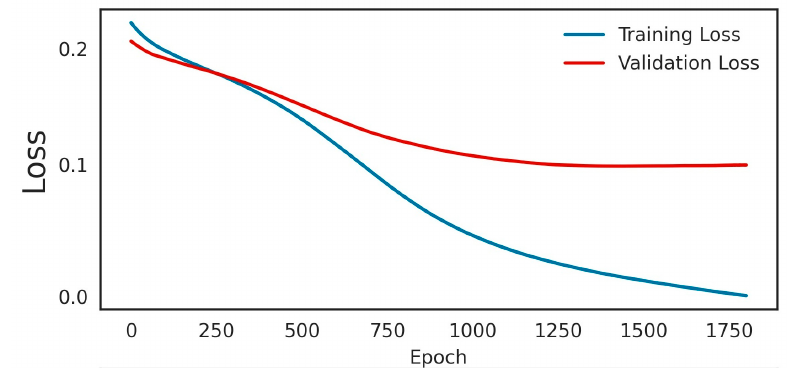
Figure 12. Loss function for landslide susceptibility assessment.